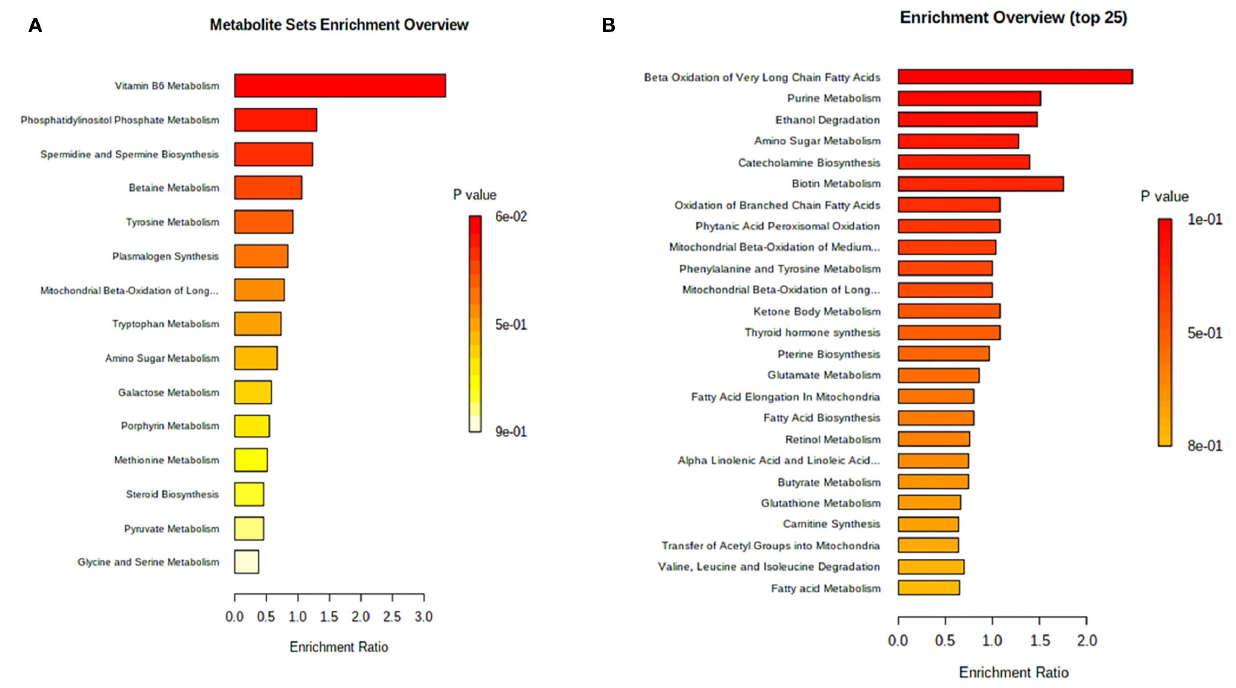
Frontiers in Veterinary Science |